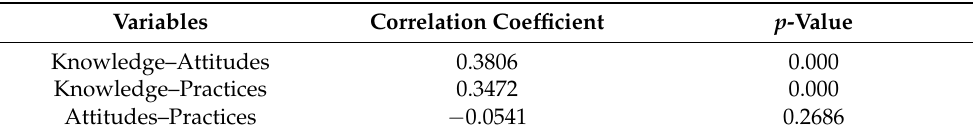
Table 7. Correlations between knowledge, attitudes, and practices of AMU and